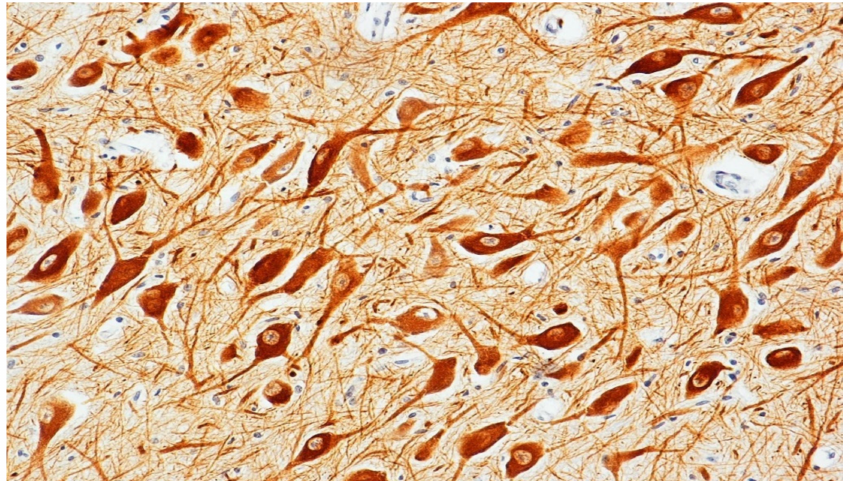
Figure 2. Tyrosine hydroxylase (TH) immunocytochemistry in a control case. Intensely dopamine-stained neuronal bodies and processes, graded as strong, are clearly visible. Original magnification, 20 ×